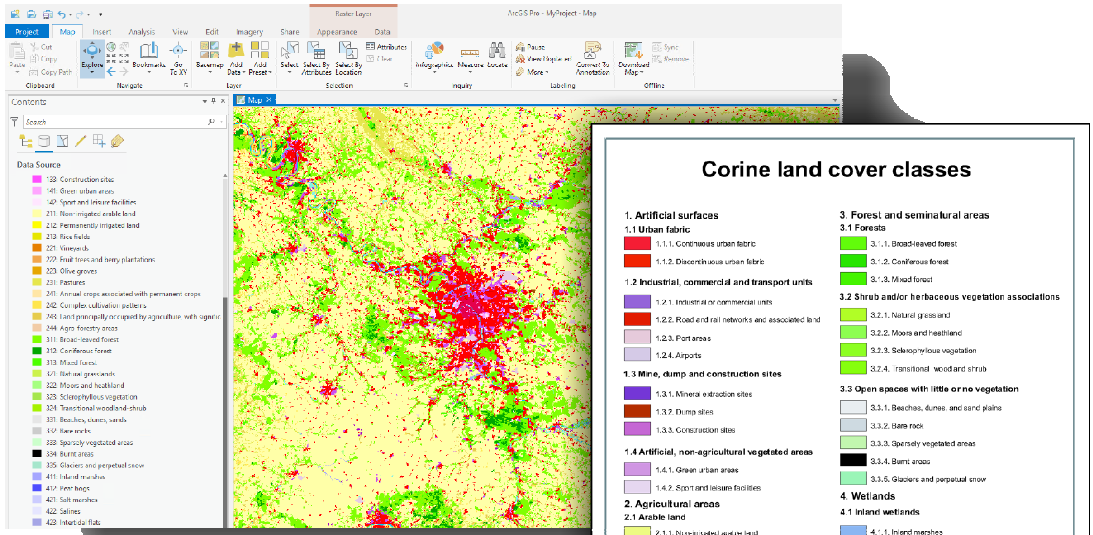
Figure 1. The class hierarchy of the CORINE land use / land cover is encoded as a three-digit number where each digit refers to one level. Reconstruction of the classes requires knowing the schema of the dataset, i.e., digit positions. The CORINE land use / land cover dataset is comprehensive and very powerful dataset, created with a lot of e ff ort, and I chose it exemplarily to illustrate the schema-free encoding using prime numbers.